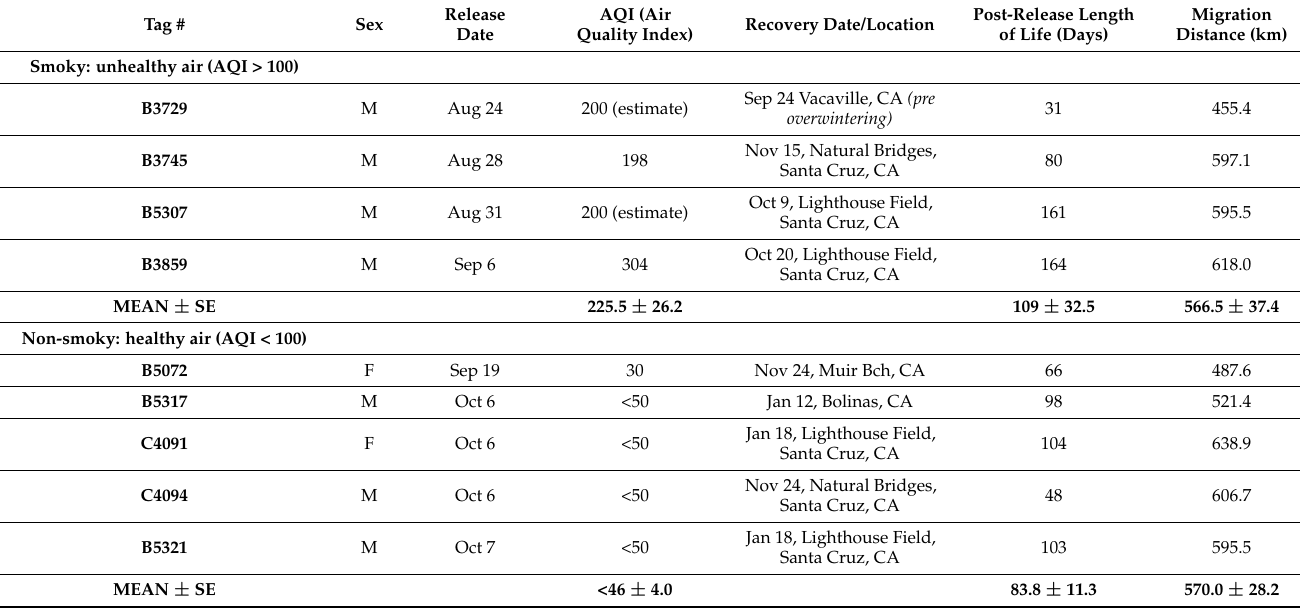
Table 9. Migration distances and lifespan of captive-reared tagged monarchs released into smoky or non-smoky air